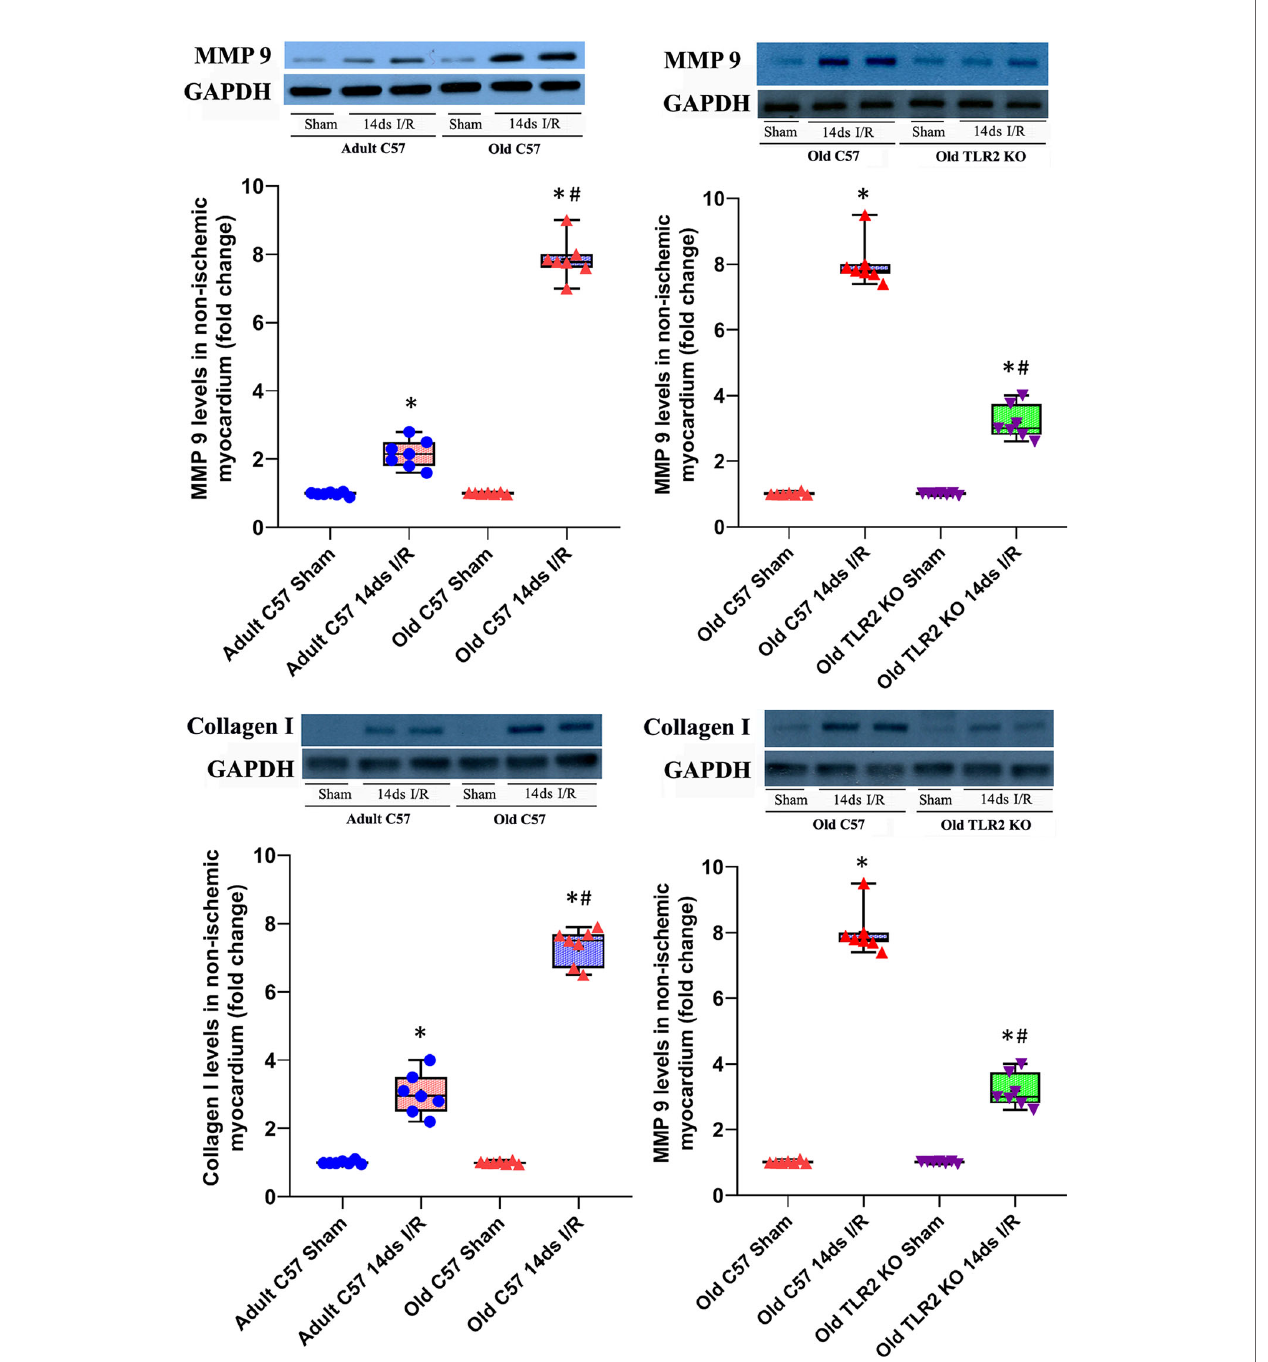
FIGURE 4 | Toll-like receptor (TLR) 2 knockout (KO) attenuates matrix metalloproteinase (MMP) 9 and collagen I expression in old mice. MMP 9 and collagen I levels in the non-ischemic myocardium were analyzed at day 14 of reperfusion after myocardial ischemia with 30 minutes of left anterior descending artery occlusion. Representative immunoblots and densitometry data show greater levels of MMP 9 and collagen I in the non-ischemic myocardium of old C57BL/6 wild-type mice in comparison to adult C57BL/6 wild type mice. Old TLR2 KO mice had signi fi cantly lower levels of these two extracellular matrix proteins MMP 9 and collagen I in the non-ischemic myocardium compared to old C57BL/6 wild type mice. Data are presented as box-and-whiskers plots; the upper and lower borders of the box represent the upper and lower quartiles; the upper and lower whiskers represent the maximum and minimum values of nonoutliers; the horizontal line in the box represents the median, and the + sign represents the mean. N = 7 in each group, * P < 0.05 vs. respective sham. # P < 0.05 vs. adult wild-type ischemia/reperfusion (I/R) or old wild type